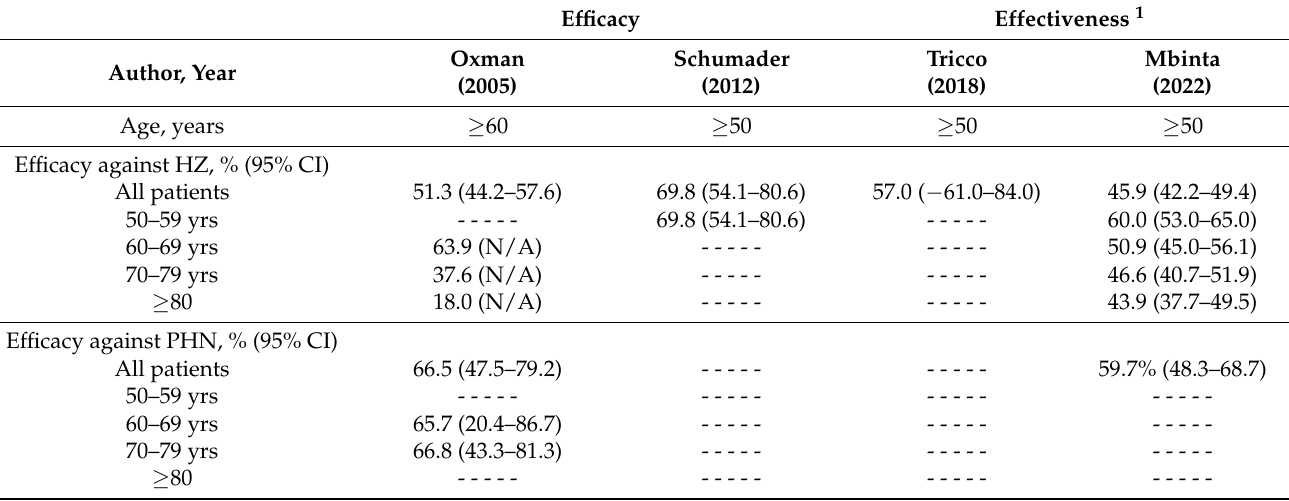
Table 1. Efficacy and effectiveness of the live herpes zoster vaccine (ZVL) in adults. Efficacy Effectiveness